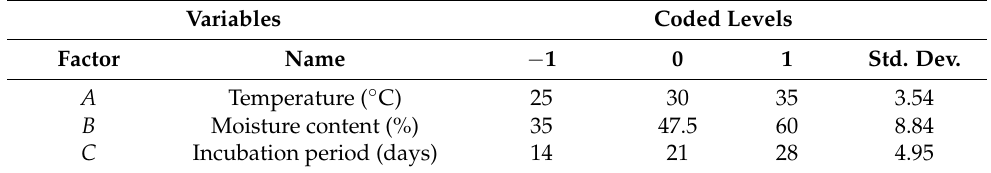
Table 4. Range, levels and code of independent variables chosen for the BBD of T. longibrachia- tum AU158. Variables Coded Levels Factor Name − 1 0 1 Std. Dev. A Temperature ( ◦ C) 25 30 35 3.54 B Moisture content (%) 35 47.5 60 8.84 C Inoculum Concentration (%) 0.1 5.05 10